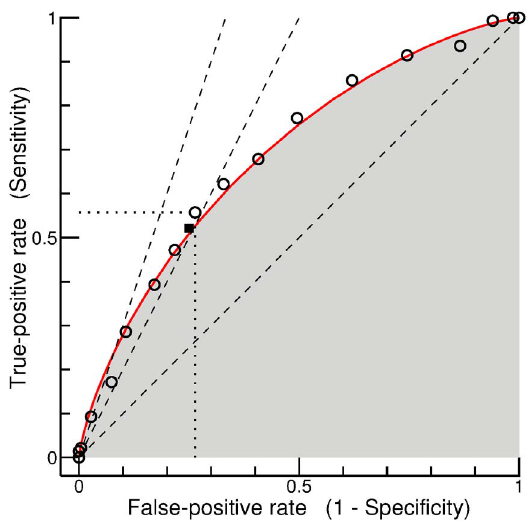
Figure 3. Receiver operating characteristic. The open circles represent the false-positive and true-positive rates displayed in Fig. 2 B, whereas the filled square represents the rule of thumb considered in Fig. 1. The three dashed lines indicate specific values of the likelihood ratio LR z (1, 2, and 3).